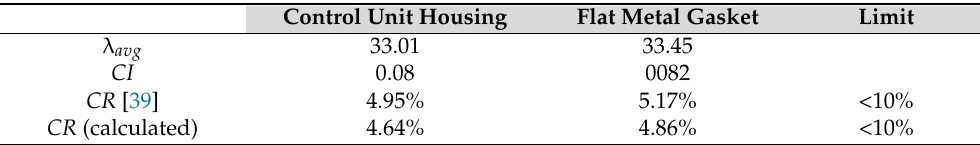
Table 5. λ avg , CI , and CR for the AHP of the control unit housing and the flat metal , CI , and CR for the AHP of the control unit housing and the flat metal gasket. Table 5. λ 𝑎𝑎𝑎𝑎𝑎𝑎